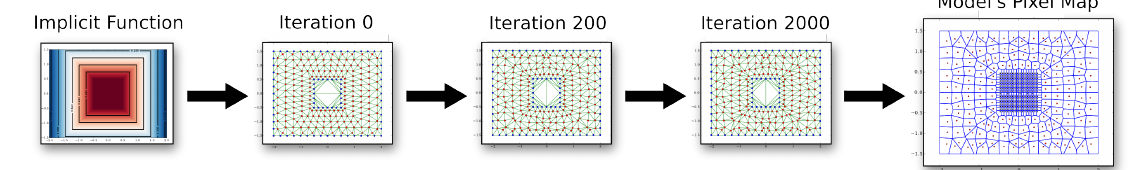
Figure 5. The evolution of an example of ARIM with 256 foveal (uniform), and 192 peripheral (non-uniform) pixels. The l ∞ is the implicit